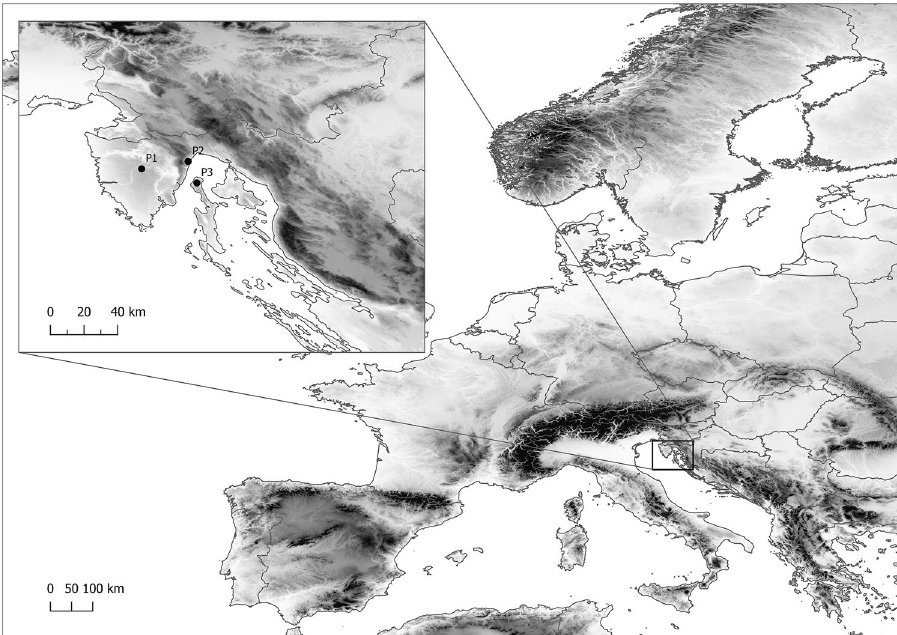
Figure 1. Geographical distribution of the three marron producing areas in the northern Adriatic region. Each of the locations with the orchards was considered a singular population, with ‘Lovrin Marron’ orchards named “Population 1” (P1), ‘Lovran Marron’ orchards as “Population 2” (P2) and ‘Cres Marron’ as “Population 3” (P3). In total, 219 trees were sampled, 44 trees in P1, 83 in P2 and 92 in P3. The map was generated using QGIS 3.10.7 (https:// qgis.